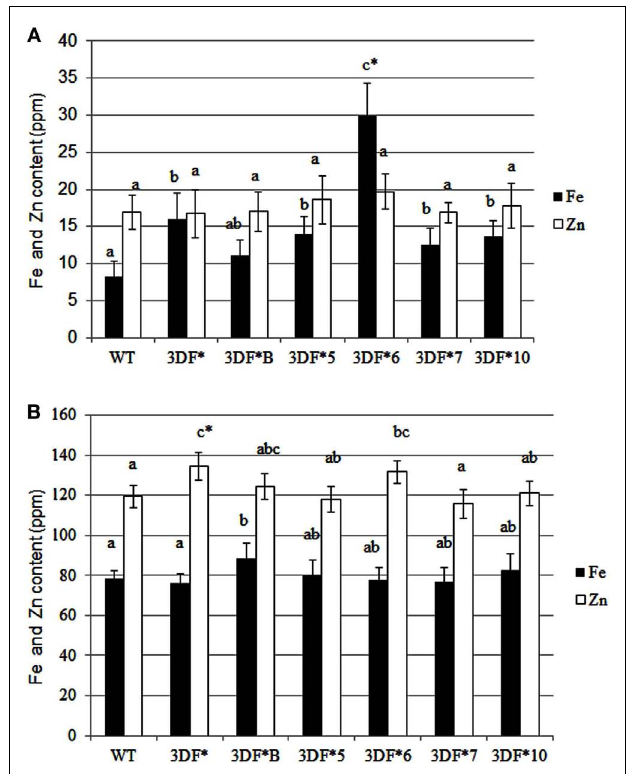
FIGURE 4 | Iron and zinc content of 9-month-old greenhouse-grown storage roots and leaves of FEA1 transgenic and wild-type plants. White bars represent zinc and black bars represent iron. (A) Iron and zinc content of cassava storage roots.WT, wild type; 3DF*, 3DF*B, 3DF*5, 3DF*6, 3DF*7, and 3DF*10 are FEA1 transgenic cassava plants. (B) Iron and zinc content of leaves from 9-month-old greenhouse-grown plants of FEA1 transgenic and wild-type cassava plants.The results represent the mean of three replicates ( ± standard deviation). *Numbers with same letters show no statistical difference, different letters mean statistical difference at 95% confidence